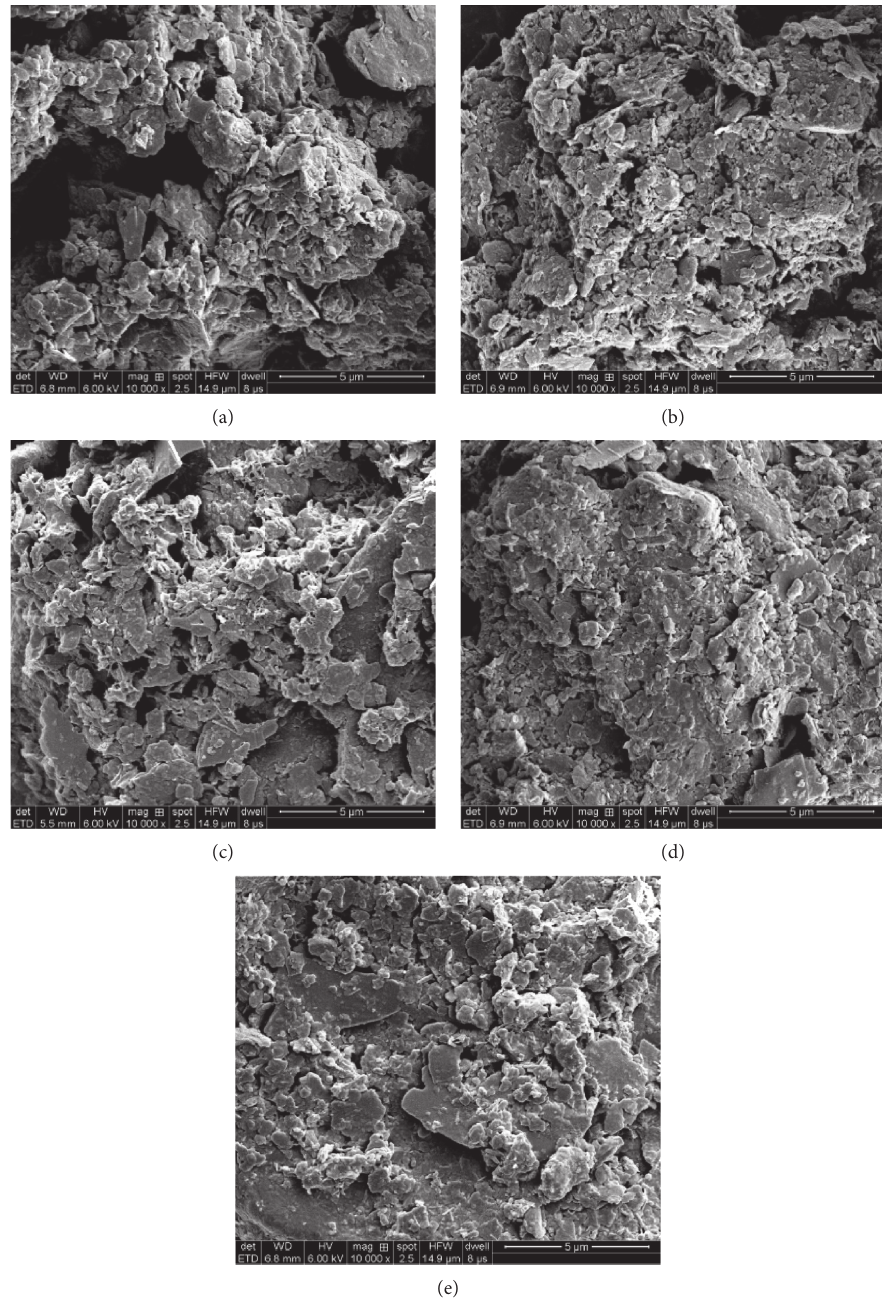
Figure 11: SEM results of bare soil and improved soil. (a) Untreated. (b) 0.1MPa. (c) 0.2MPa. (d) 0.3MPa. (e) 0.4